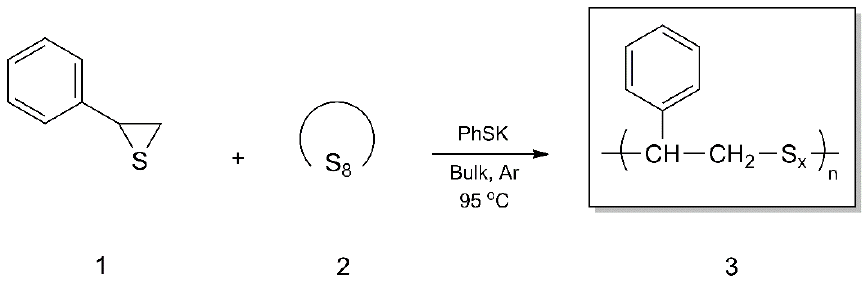
Figure 1. Copolymerization of styrene sulfide ( 1 ) with elemental sulfur (S 8 ).